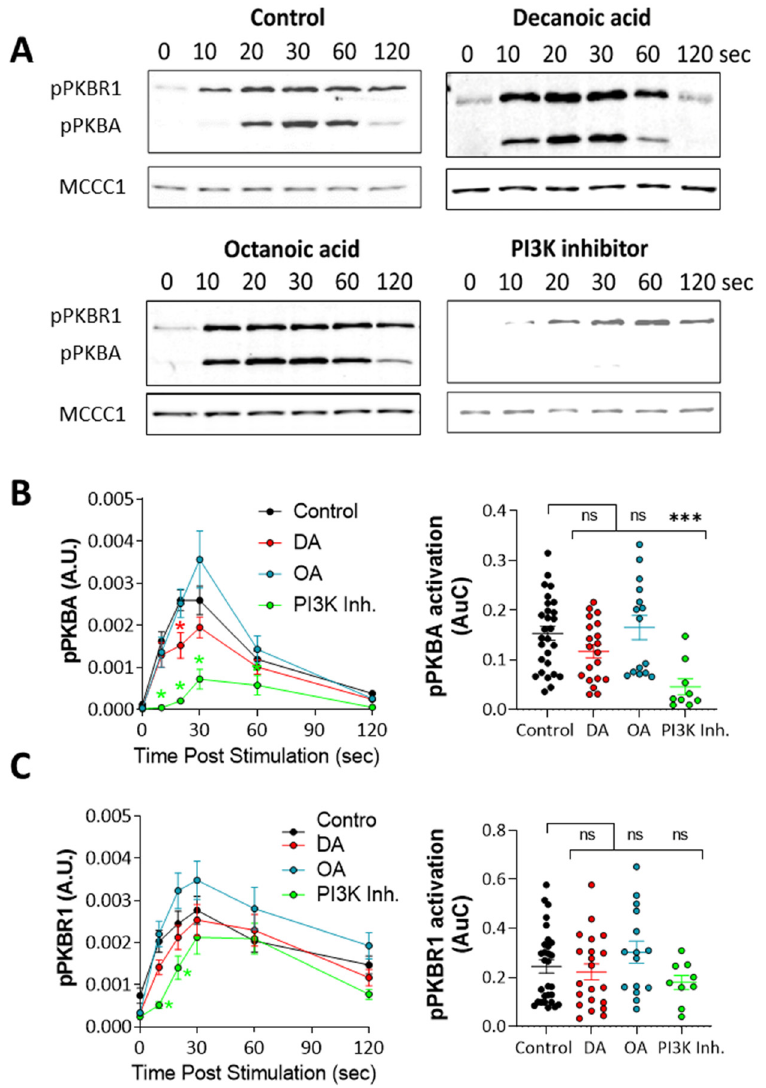
Figure 4. Medium-chain fatty acids do not reduce protein kinase B (PKB) phosphorylation in Dicty- ostelium at concentrations that trigger autophagy. To visualize the activation of PKB, cells in early development were treated with decanoic acid or octanoic acid (both at 60 μ M, 4 h), PI3K inhibitor (100 μ M LY294002, 15 min), or solvent control (DMSO) and stimulated with 1 μ M cAMP to trigger transient phosphorylation of PKBA, and PKBR1 over 120 s was visualized by western analysis. ( A